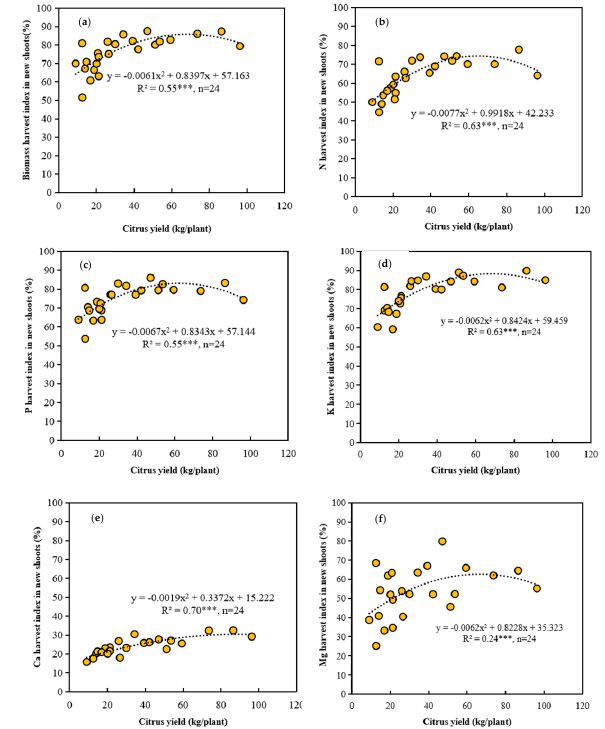
Figure 3. Relationships between citrus yields (kg / plant) and biomass ( a ), nitrogen ( b ), phosphorus ( c ), potassium ( d ), calcium ( e ) magnesium ( f ) harvest in new shoots (%). The letters denote the panels. *** indicated significance at p <